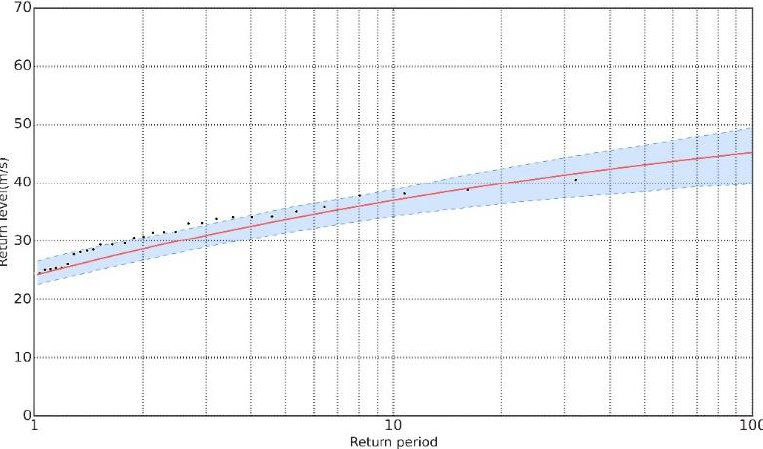
Figure 24. Regression curve of the wind speed at the Xisha Islands using POT-GPD method.